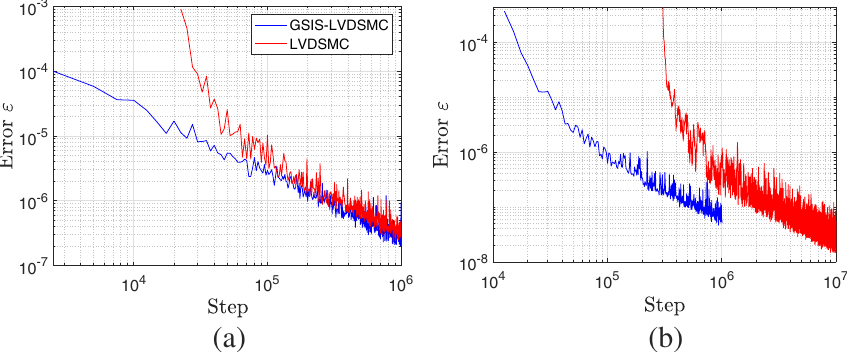
Fig. 7 The relative error ε as a function of the iteration step in the 1D Poiseuille flow solved by GSIS-LVDSMC (blue lines) and LVDSMC (red lines) when a Kn = 0.1 and b Kn = 0.01 . The sampling starts when the